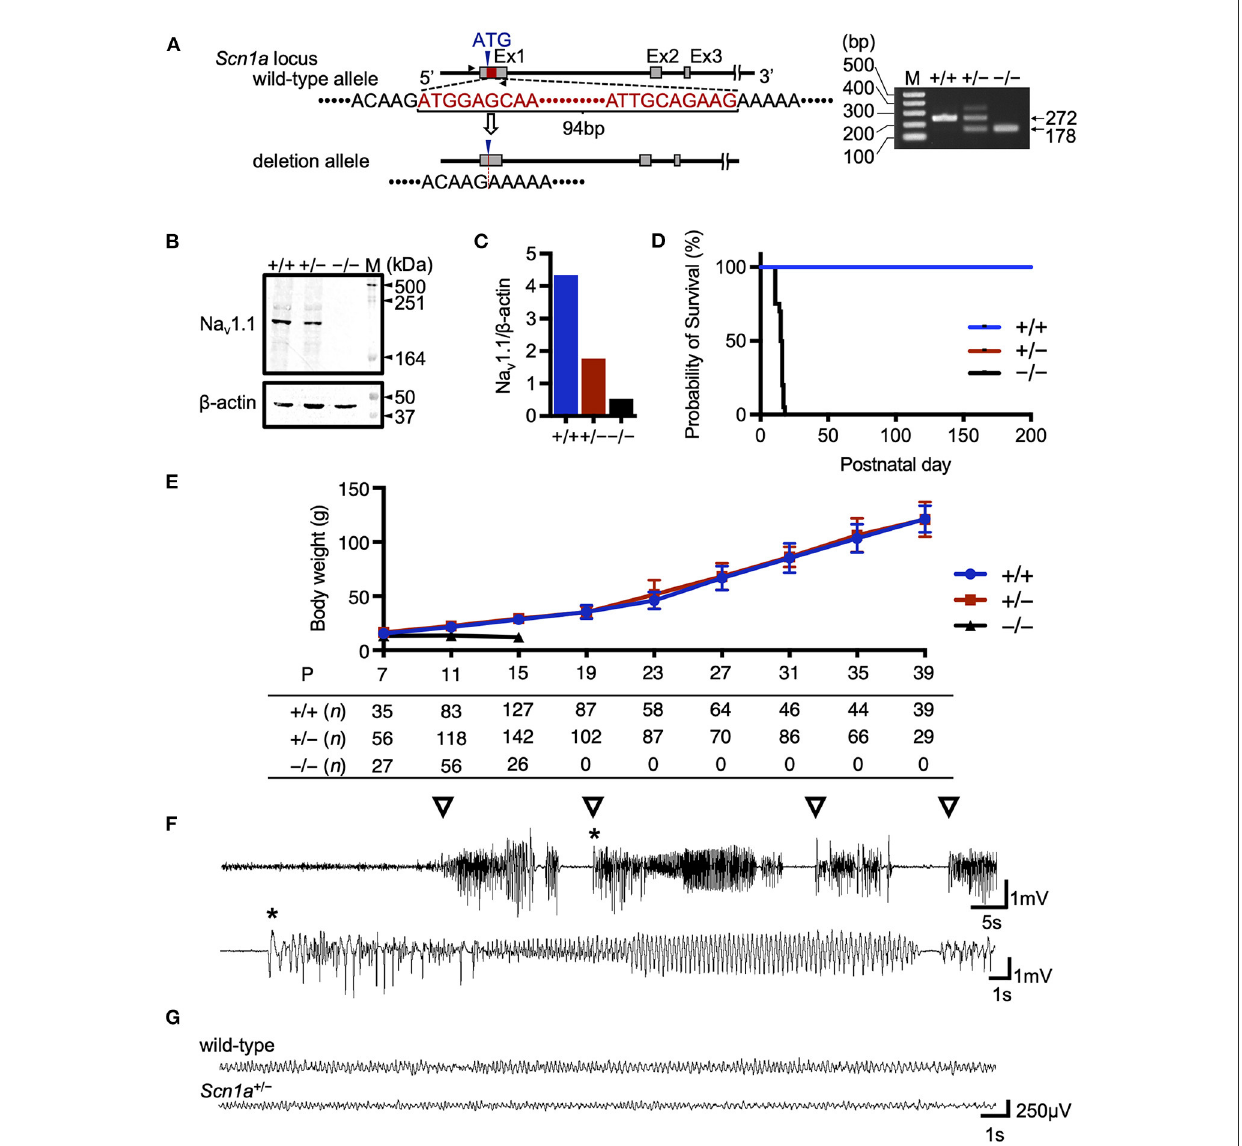
FIGURE1 Targeting construct and generation of global Scn1a knockout rats. (A) The arrows show the position of the genotyping primer set (forward 5 ′ -TAATAACTTTTAATGCTATC-3 ′ , reverse 5 ′ -CTTCCCAGCTTCCAAGTCAC-3 ′ ). Genotype analysis shows a 272 bp band in the wild-type allele and a 178 bp band in the Scn1a em1kyo mutant. The upper band of the Scn1a em1kyo mutant is nonspecific. Genotypes are indicated by + / + for wild-type, + /– for heterozygous, and –/– for homozygous animals. (B) Western blotting of brain membrane proteins from wild-type ( + / + ), heterozygous ( + /–), and homozygous (–/–) Scn1a rats at P13 using an anti- voltage-gated sodium channel alpha subunit 1 (Na V 1.1) antibody. β -actin was used as the internal control. Original blots/gels are presented in Supplementary Figure 1. (C) Relative Na V 1.1 protein levels normalized to β -actin. (D) Survival curves of wild-type ( n = 15), Scn1a + / − ( n = 15), and Scn1a − / − ( n = 20) rats. Scn1a − / − rats exhibited ataxia and seizures from postnatal day (P) 10, gradually progressing to weight loss and complete loss of postural control. They became inactive and did not survive beyond P18. In wild-type and Scn1a + / − rats, there were no spontaneous deaths. (E) Body weight curves of wild-type (blue circle), Scn1a + / − (red square), and Scn1a − / − (black triangle) rats. The sample size is shown below the graph. Scn1a + / − rats showed no difference in body weight compared to wild-type rats. Data are presented as mean ± standard deviation. (F) Ictal electroencephalography (EEG) recording of heat-induced seizures from Scn1a + / − rats at P21. Spiking activity was recorded, and generalized tonic-clonic seizures were observed. Open triangle indicates seizure onset. Asterisk indicates the expanded EEG trace of spiking activity. (G) Representative interictal EEG recordings from wild-type and Scn1a + / − rats at P21. No interictal epileptic discharge was found.